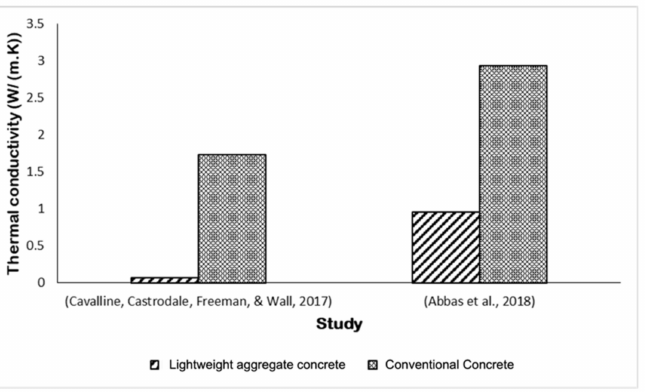
Figure 7. Previous studies’ comparison on thermal conductivity between lightweight aggregate concrete and conventional